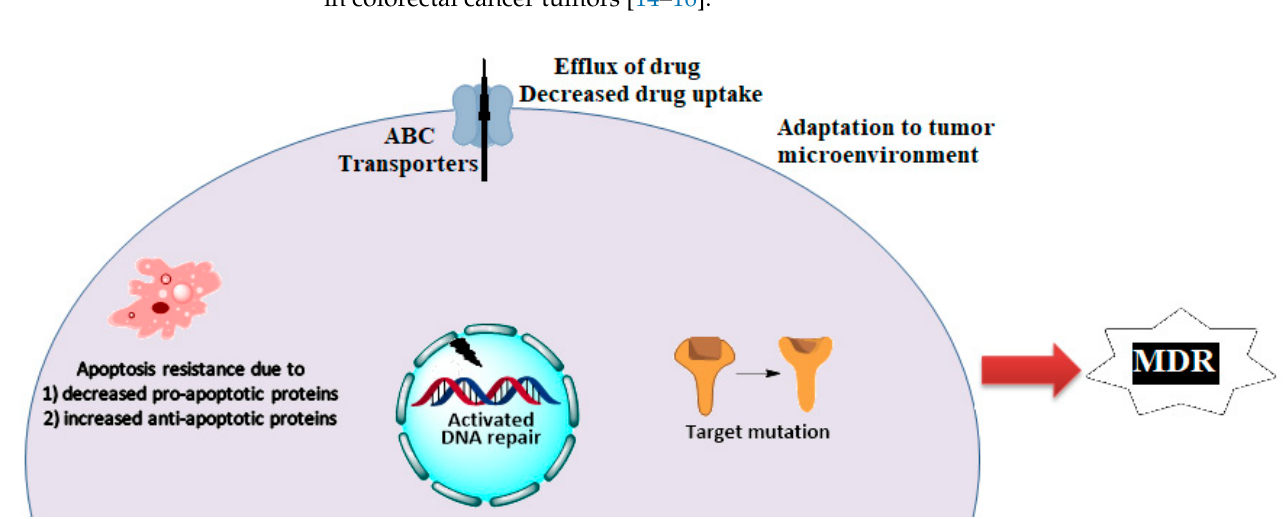
Scheme 1. Mechanisms of Multidrug resistance in